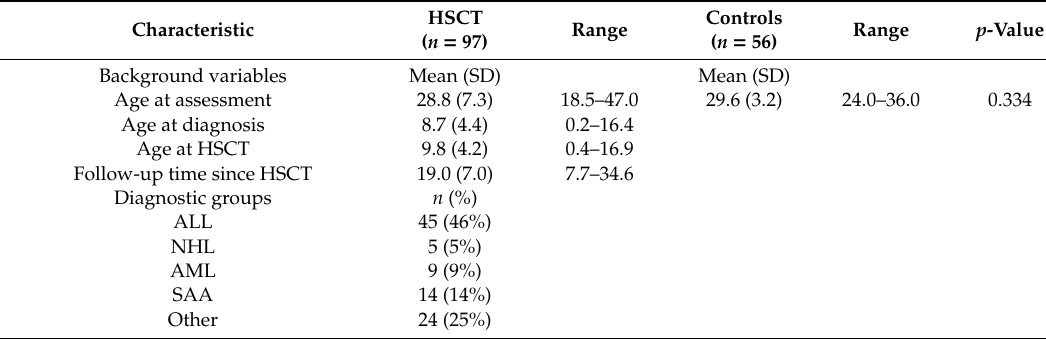
Table 1. Background and laboratory characteristics in pediatric hematopoietic stem cell transplantation (HSCT) survivors and